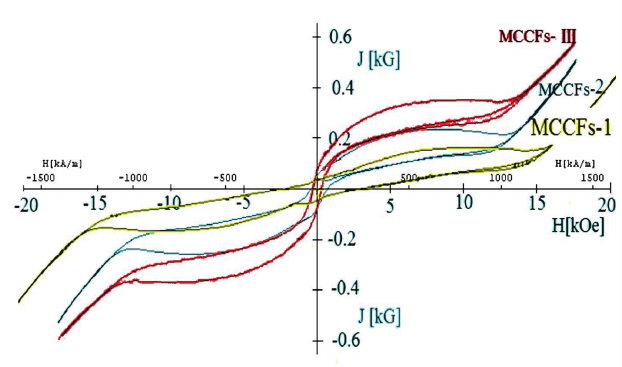
Fig. 4. The magnetic hysteretic loops of magnetite coated carbon fibers prepared at 80 o C (MCCFs-2), 60 o C (MCCFs-1) and pre - pared with a three step deposition process